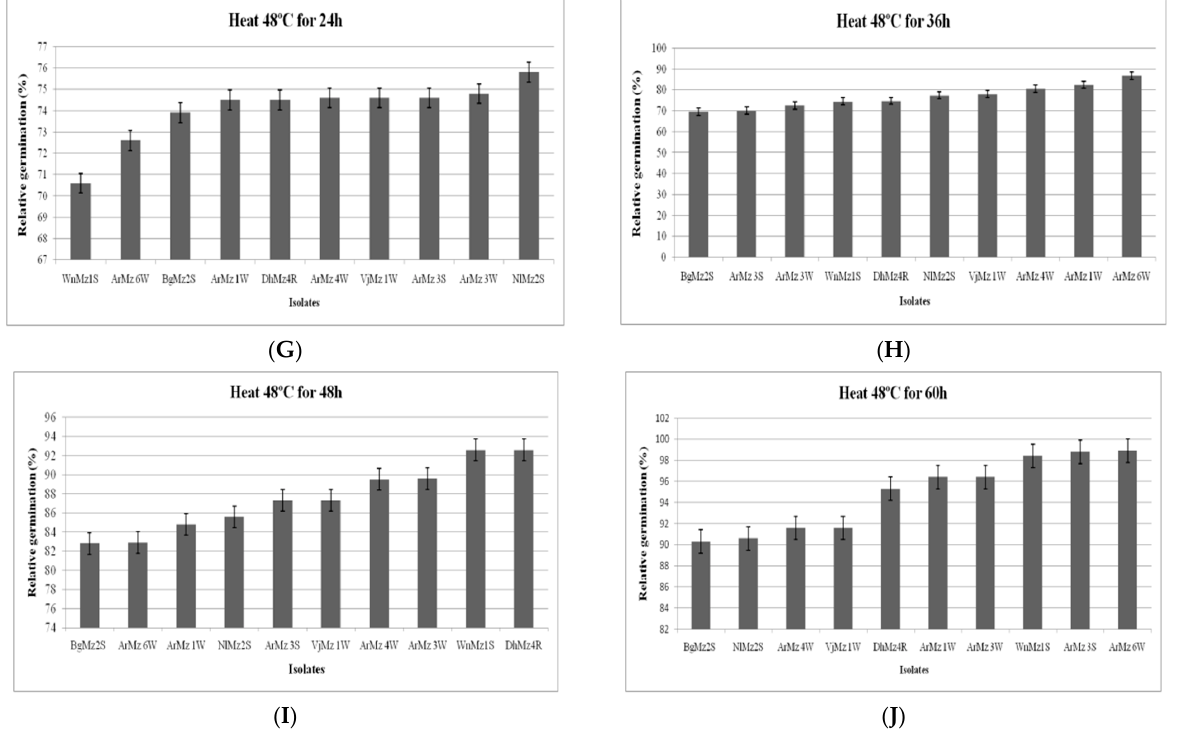
Figure 7. Relative germination of different isolates of Metarhizium sp. exposed at 48 °C. Relative germination (RG) of Metarhizium spp. conidia exposed for ( A ) 2 h, ( B ) 4 h, ( C ) 6 h, ( D ) 8 h, ( E ) 10 h, ( F ) 12 h, ( G ) 24 h, ( H ) 36 h, ( I ) 48 h, and( J ) 60 h. RG was calculated in relation to non-heated controls.